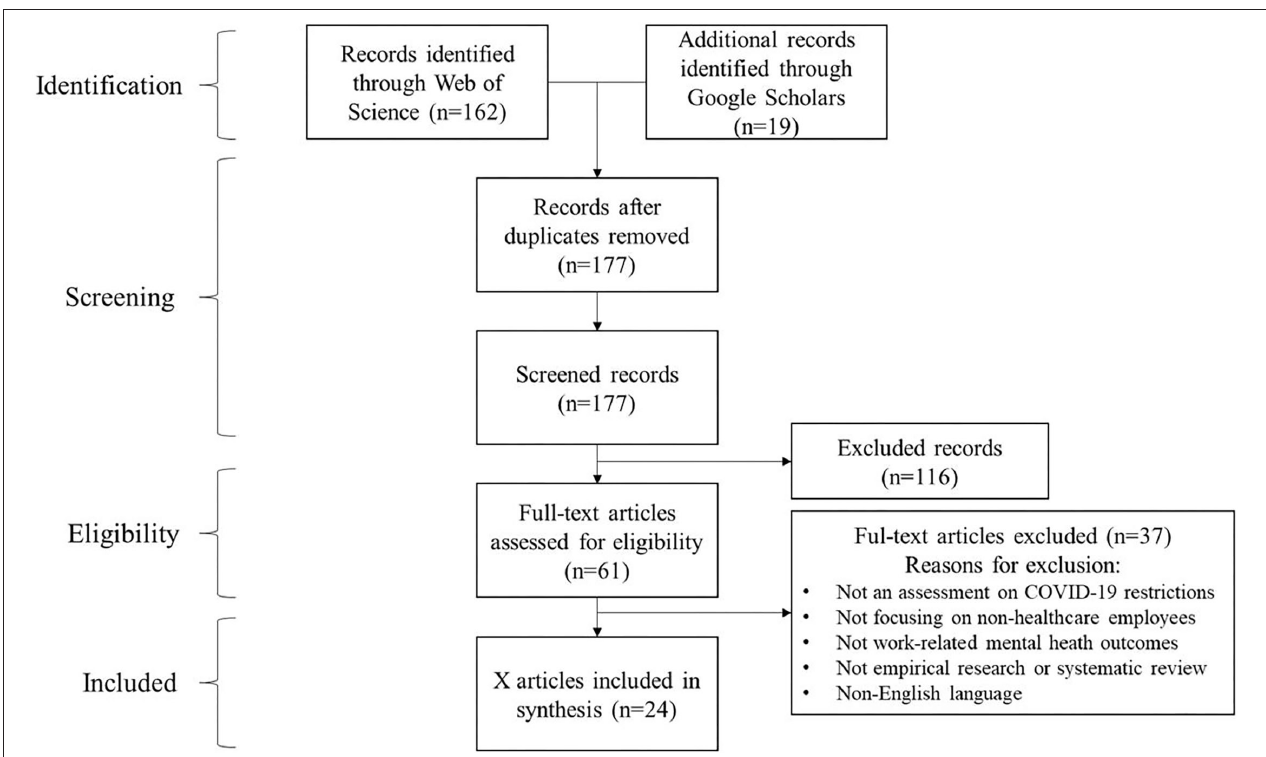
FIGURE 1 | Literature search strategy, following PRISMA flow diagram